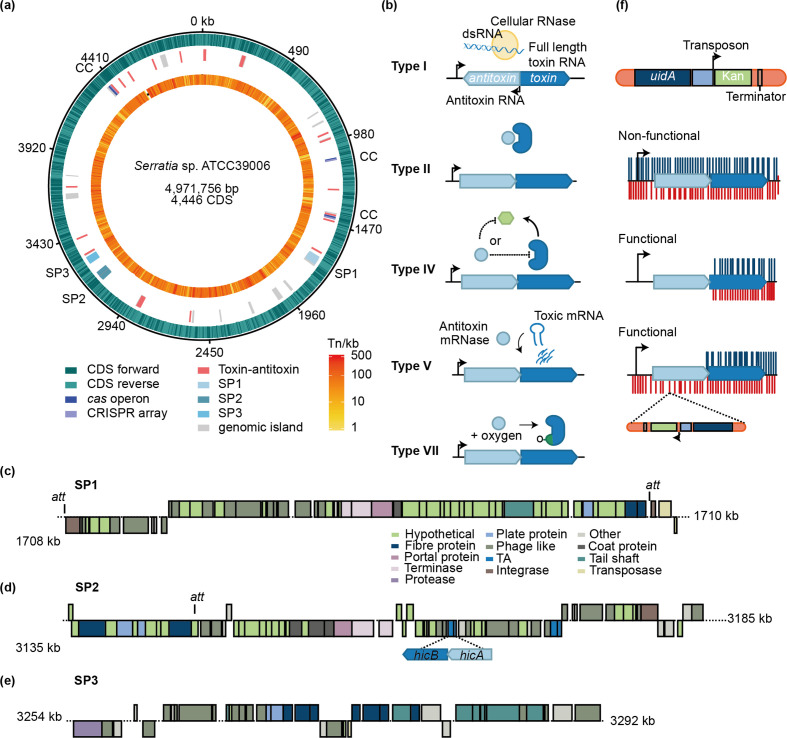

Serratia
 contains 32 TA systems. (a) Genome map of
Serratia
 showing locations of TA systems, cas operons and CRISPR arrays (CC), prophages and predicted genomic islands. The orange ring shows the 374 000 unique transposon insertions (scale: insertion density kb−1) CDS= coding sequence. (b) Models for type I, II, IV and V TA systems. (c, d and e) Schematics of prophages (c) SP1, (d) SP2 and (e) SP3 showing TA system locations. (f) The Tn5 transposon used, and transposon insertion in a non-functional, a functional and a functional TA system with insertions in the reverse strand of the antitoxin that disrupt transcription across the operon and, thus, no toxin is transcribed.